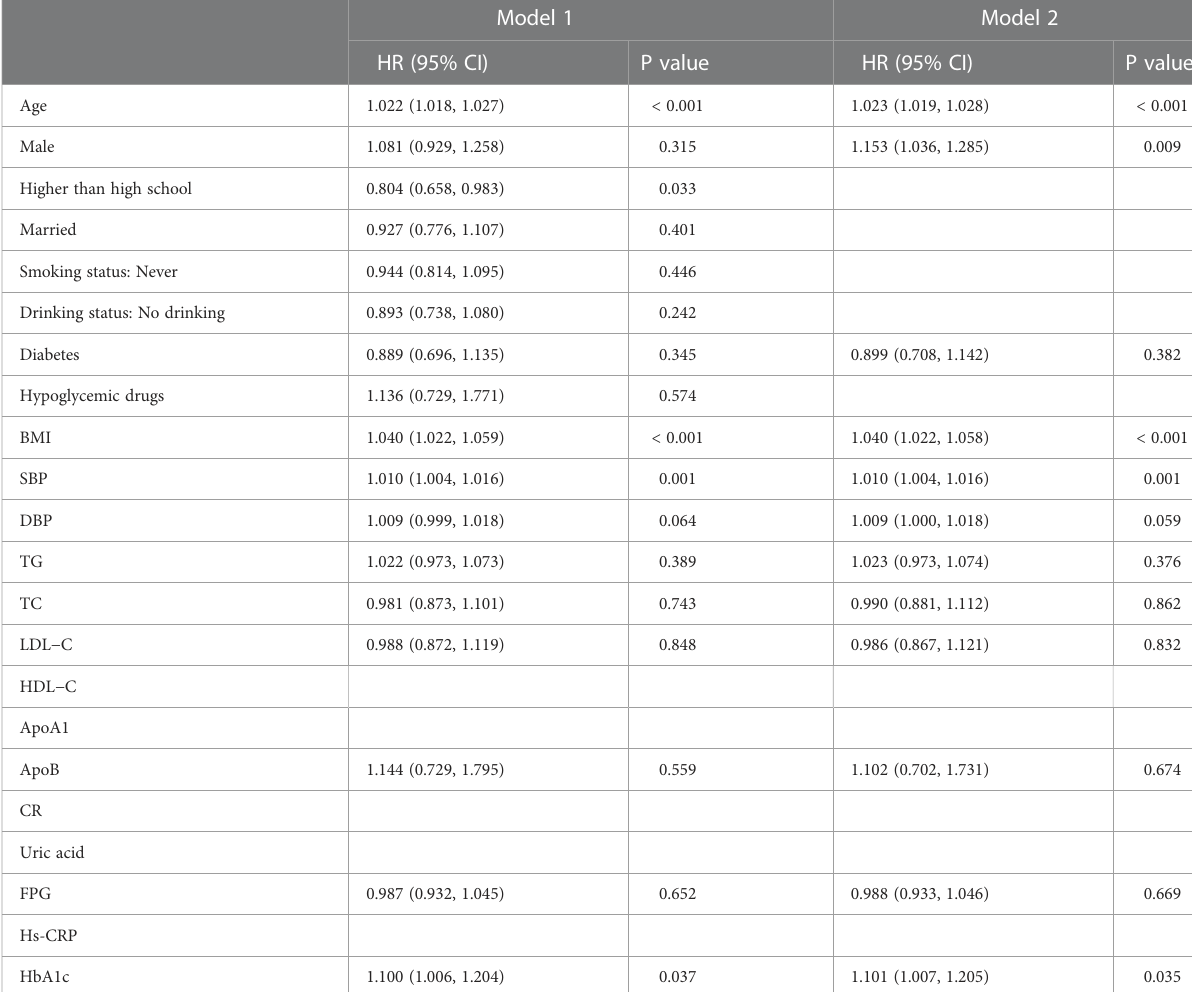
TABLE 4 Sensitivity analysis for the association between HbA1c and the incidence of